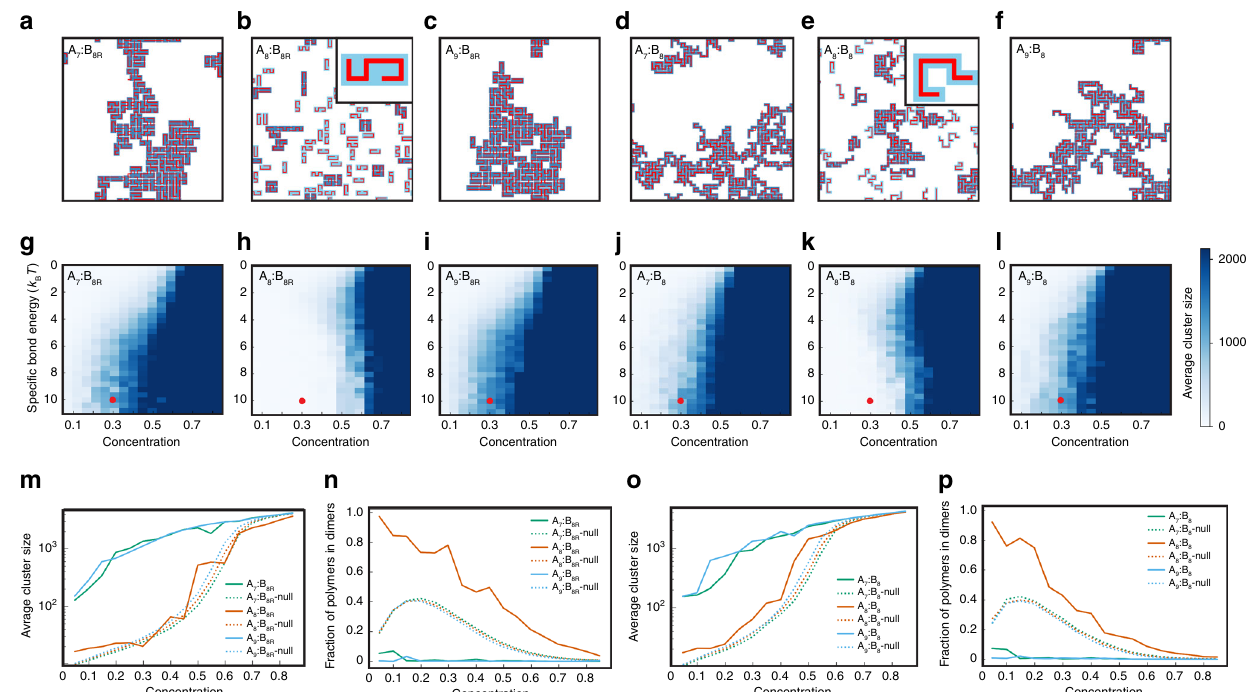
, b A 8 : B 8 , c A 9 : B 8 , R R R denotes rigid 4 ´ 2 rectangles. R T , A : B monomer ratio = 1, monomer concentration = 0.3. Insets for the magic- B : B , A : B , A : B systems (solid 7 8 R 8 8 R 9 8 R 7 : B 8 R , A 8 : B 8 R , A 9 : B 8 R systems (solid T , i.e., : B , A : B , A : B systems (solid curves) with speci fi c bond energy 10 k 7 8 8 8 9 8 B con fi rms the picture of an entropy-driven phase transition in :B magic-number system is dominated by dimers which the A 8 8R at low concentration and a condensed phase at high concentra- :B and A :B non-magic-number tion. By contrast, the A 7 8R 9 8R systems never have a high dimer fraction (Fig. 1n). Even at low concentrations, the polymers tend to aggregate into clusters to form as many bonds as possible. Magic-number effect is weaker if both components fl exible . In